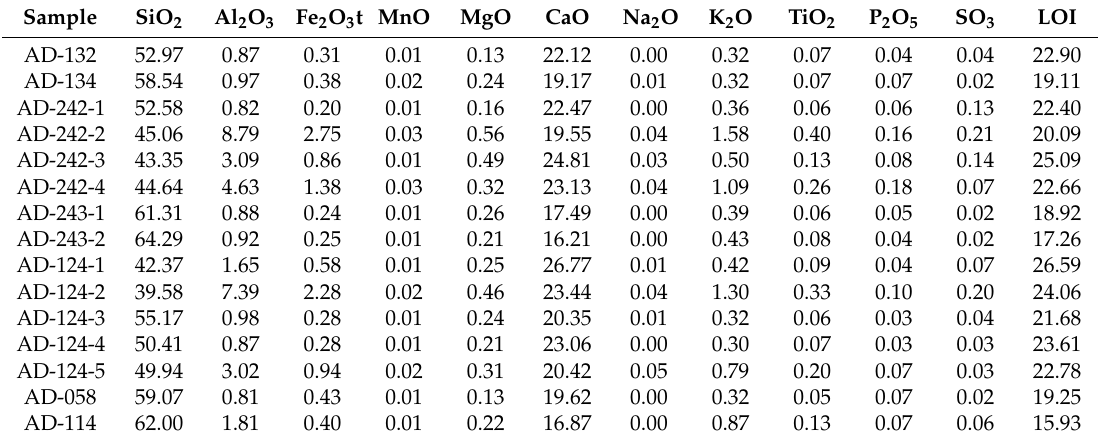
Table 3. Major element chemical composition of mortars by X-ray fluorescence (XRF) analysis (in wt%). Sample